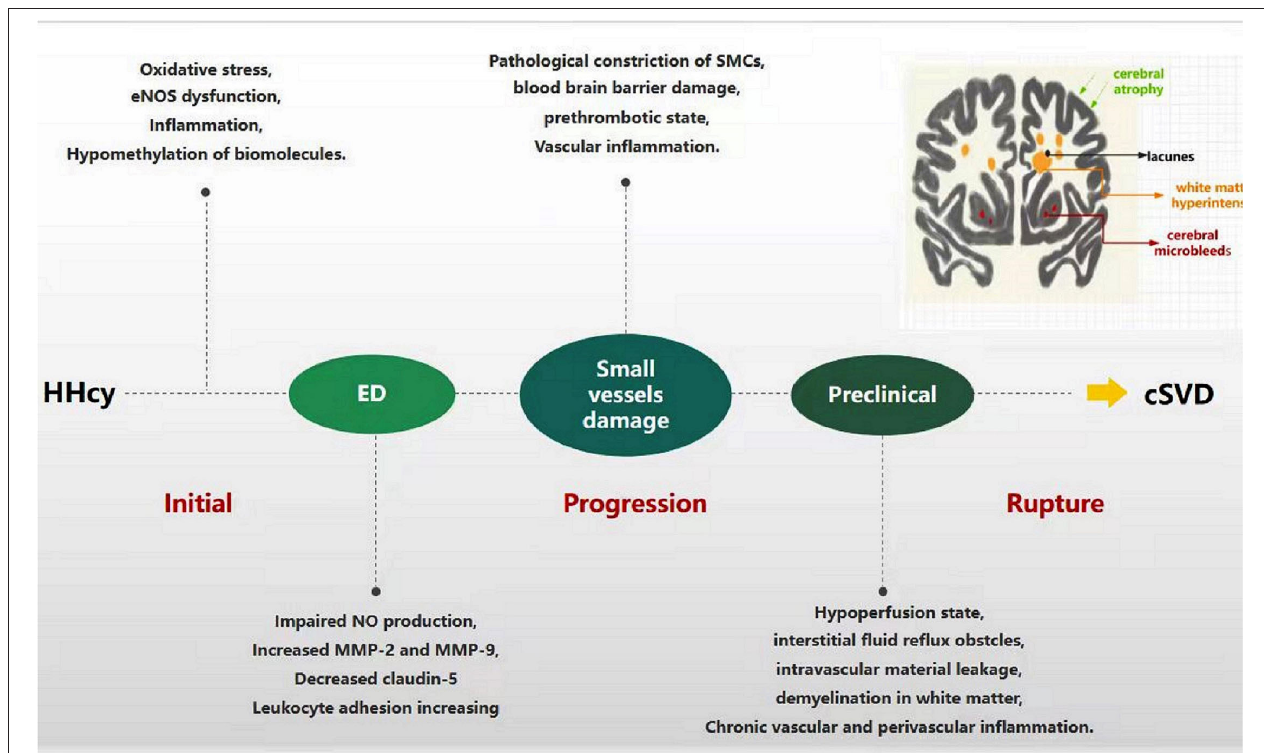
FIGURE 3 | Progression of HHcy-induced cSVD through ED. In the beginning, HHcy induces endothelial cell injury through oxidative stress, eNOS dysfunction, inflammation, and hypomethylation of biomolecules. Dysfunctional endothelia release the molecules abnormally, such as impaired NO production, increased MMPs and adhesion factors, decreased claudin-5. The process facilitates the damage of small vessels, including pathological vasoconstriction, SMCs injury, blood-brain barrier damage, pre-thrombotic state and vascular inflammation. Along with these pathological changes progression, hypoperfusion, intravascular material leakage, demyelination, chronic vascular and perivascular inflammation appear successively, which eventually develop into